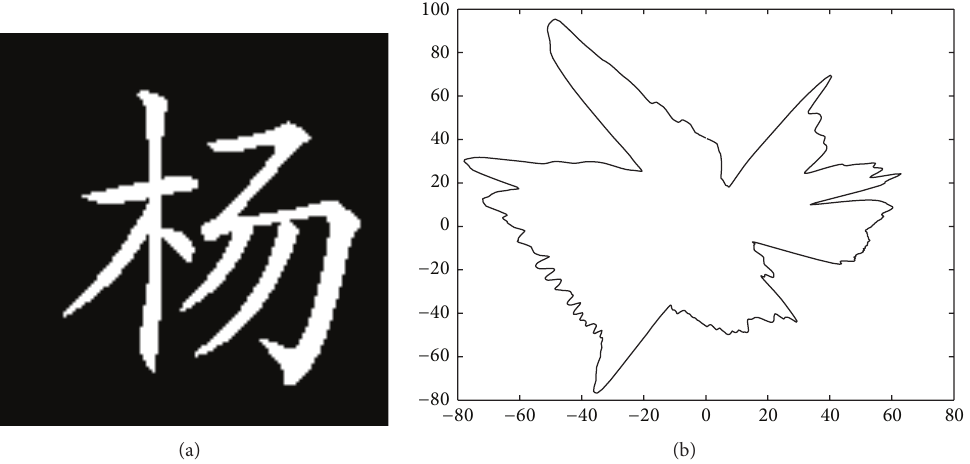
Figure 2: (a) The Chinese character “Hai”. (b) GC derived from (a).